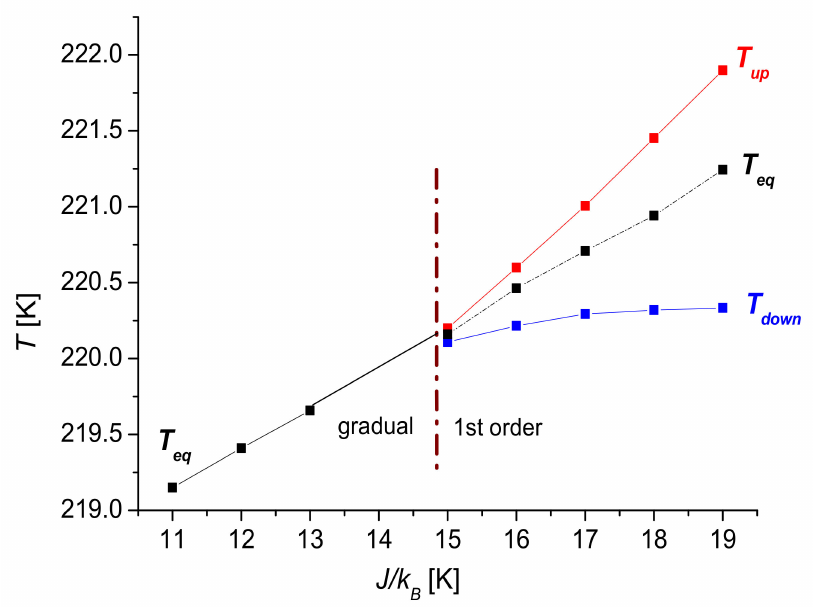
Figure 6. Phase diagram T = f ( J/k B ) for a 10 × 10 square lattice. The red and blue squares correspond, respectively, to the upper and lower transitions for the heating ( T up ) and cooling ( T down ) temperatures of the thermal HS fraction. The black squares correspond to the equilibrium temperatures ( T eq ). The computational parameters are: ∆ / k B = 1300 K, G / k B = 172.2 K, x = ( J HH / J LL ) = 0.4 and ln( g ) = 6.01.